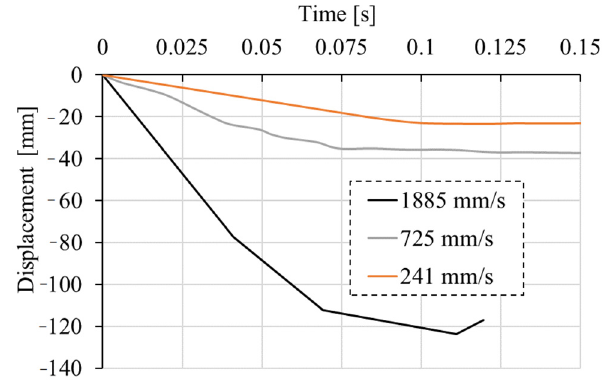
Figure 17. Applied displacement time histories of the pendulum.